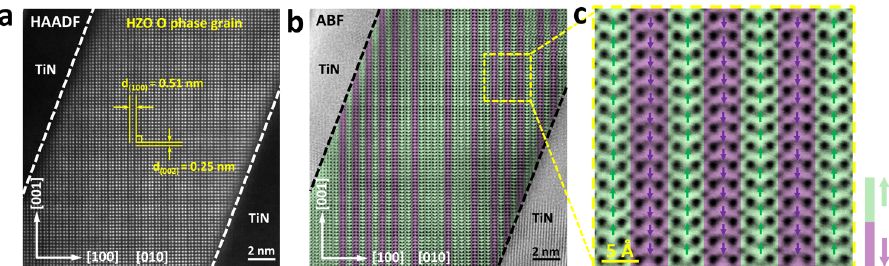
Fig. 4 Phase transition from O FE Pbc 2 1 to O AFE Pbca phase after fatigue process. a Cross-section HAADF image of the TiN/HZO/TiN device after fatigue at V a = ±2.5 V, f = 500 kHz, for 10 7 times. The image shows an O-phase grain projected along [010] zone axis. b The corresponding ABF image of a , demonstrating clearly the off-center O II atomic columns shifted along the [001] direction (green) and [00 (cid:1) 1] direction (purple) alternately, showing a Pbca dominated structure. c The magni fi ed ABF image acquires from the green square area in b , and the arrows show the deviating direction of O II atomic columns from the center of the four nearest